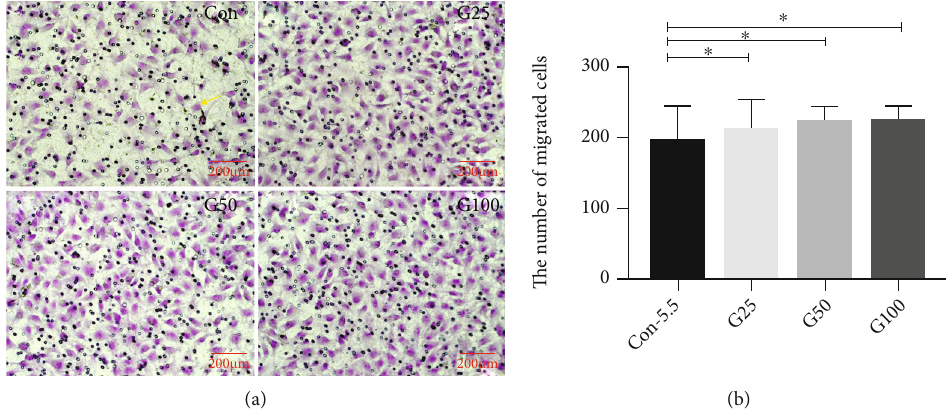
Figure 2: Cell migration ability detected by Transwell assay. (a) Representative images of migrated HRMECs treated with 5.5mM, 25mM, 50mM, and 100 mM glucose, respectively, at 48 h. HRMEC cells were stained with 0.1% crystal violet (yellow, arrows). (b) The number of migrated HRMEC was signi fi cant higher in the 25 mM ( 238 ± 29 vs. 200 ± 42 , p = 0 : 026 ), 50mM ( 230 ± 16 vs. 200 ± 42 , p = 0 : 021 ), and 100mM ( 228 ± 18 vs. 200 ± 42 , p = 0 : 031 ) groups in comparison with the 5.5mM groups. Scale bar: 200 μ m (a). HRMEC: human retinal vascular endothelial cells; Con: control group (5.5 mmol/l); G25: 25 mmol/l; G50: 50 mmol/l; G100: 100 mmol/l. ∗ p < 0 : 05 .